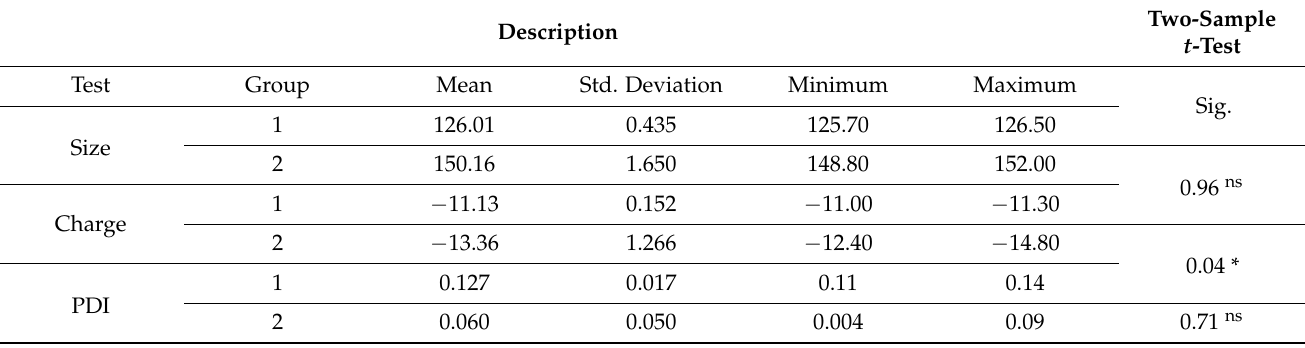
Table 1. Effect of 6-gingerol on nanoparticle characterization. Description